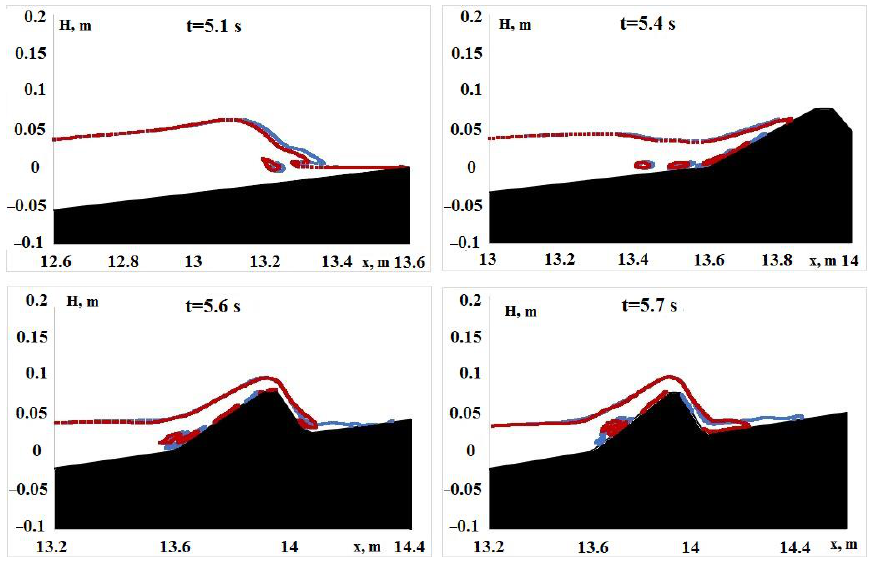
Figure 5. Comparison of the wave profiles for setup 2 ( —without TM, —with TM).